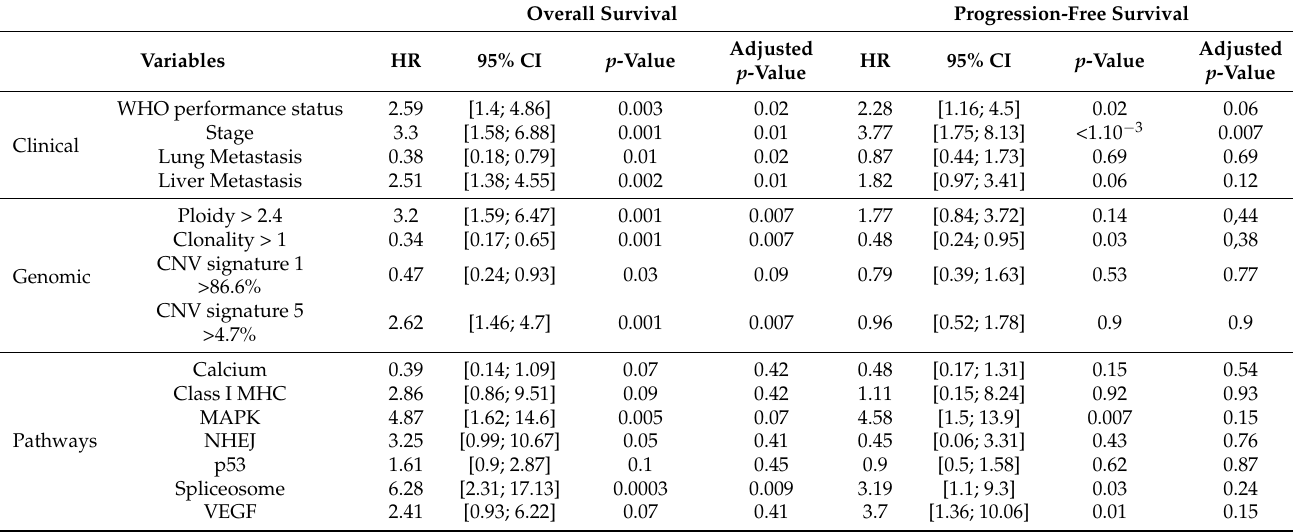
Table 2. Univariate Cox model for overall and progression-free survival in the FOLFIRINOX cohort. For each type of variable, only results significant for OS are